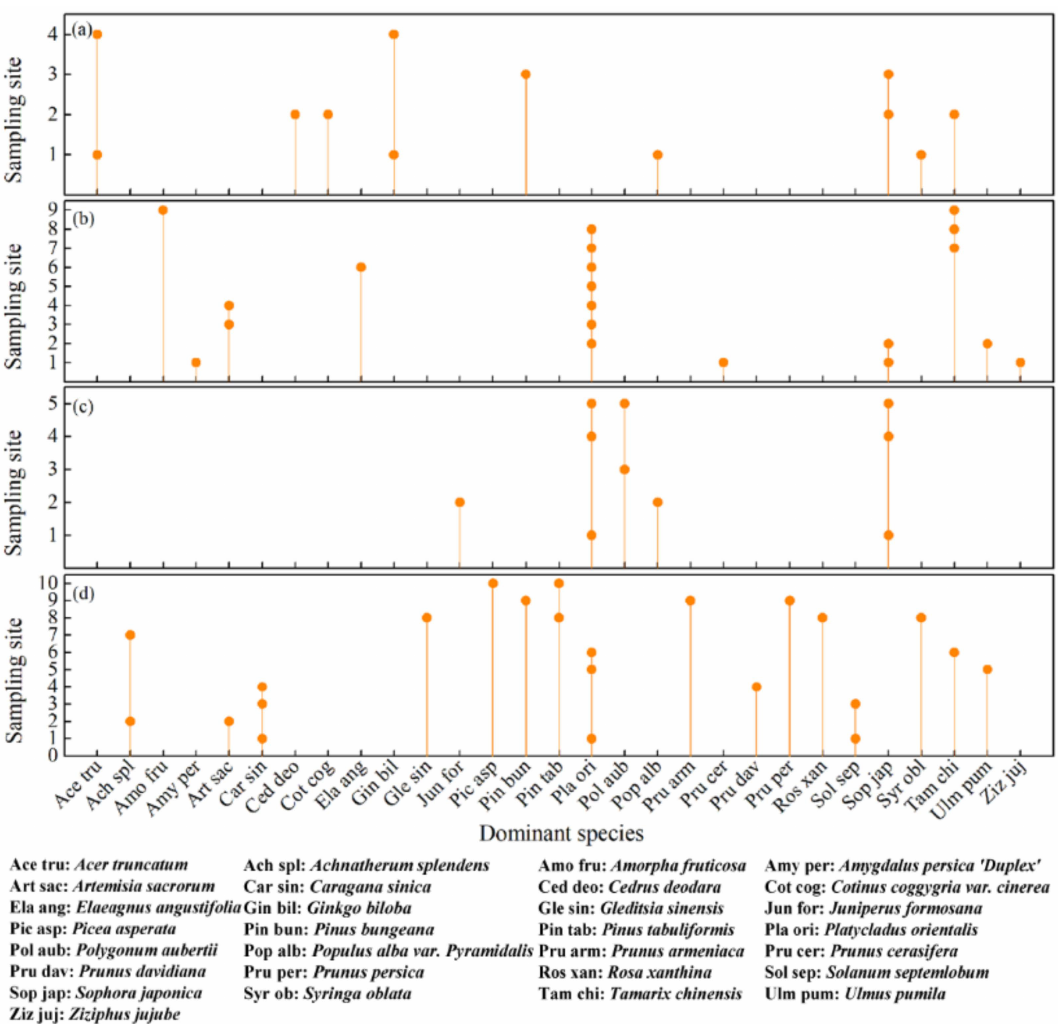
Figure 6. Spatial variation in the dominated species of each sampling site along altitude gradient within Jincheng ( a ); Renshoushan ( b ); Baitashan ( c ); and Lanshan ( d )